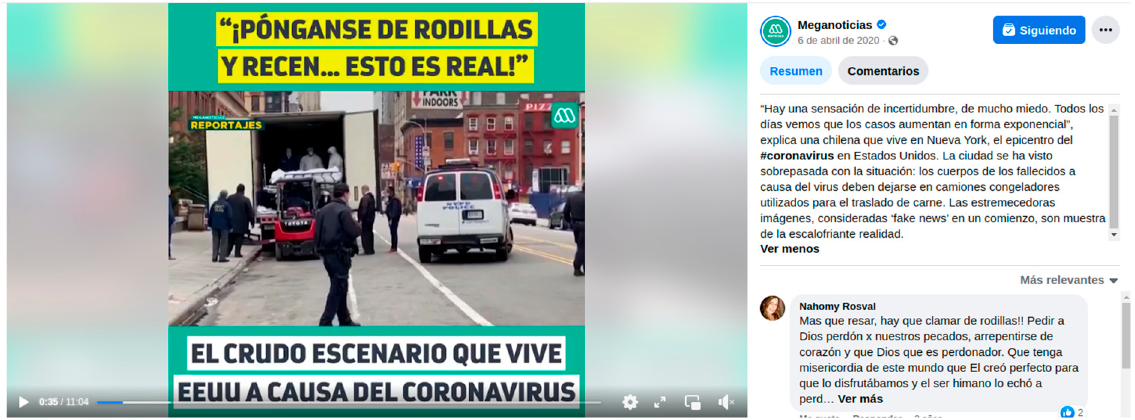
Figure 6. Exemplary case in Facebook.